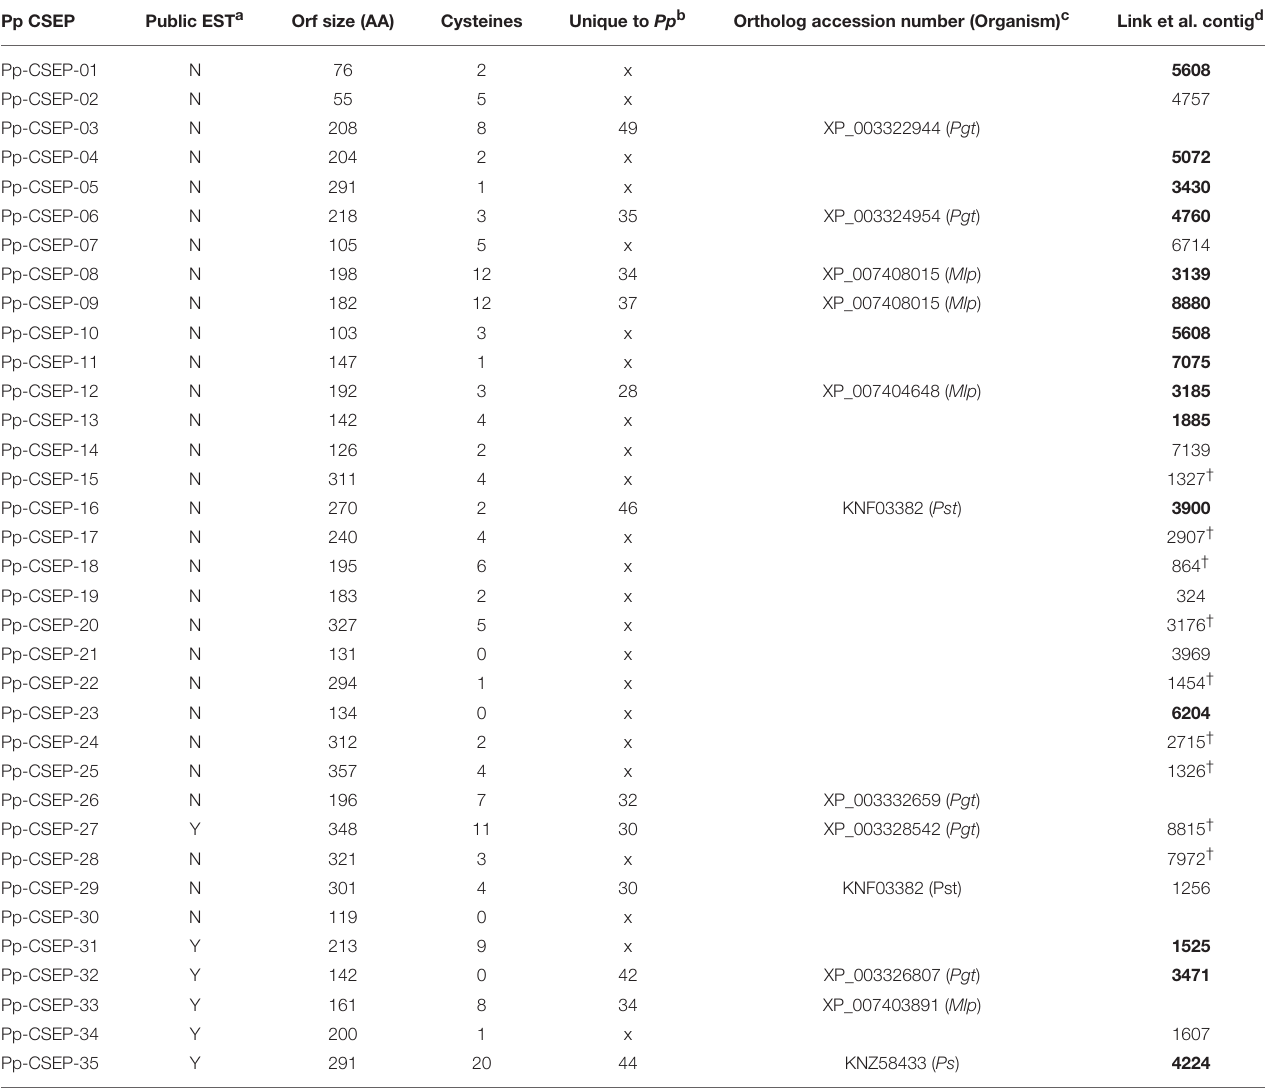
TABLE 1 | Candidate Phakopsora pachyrhizi